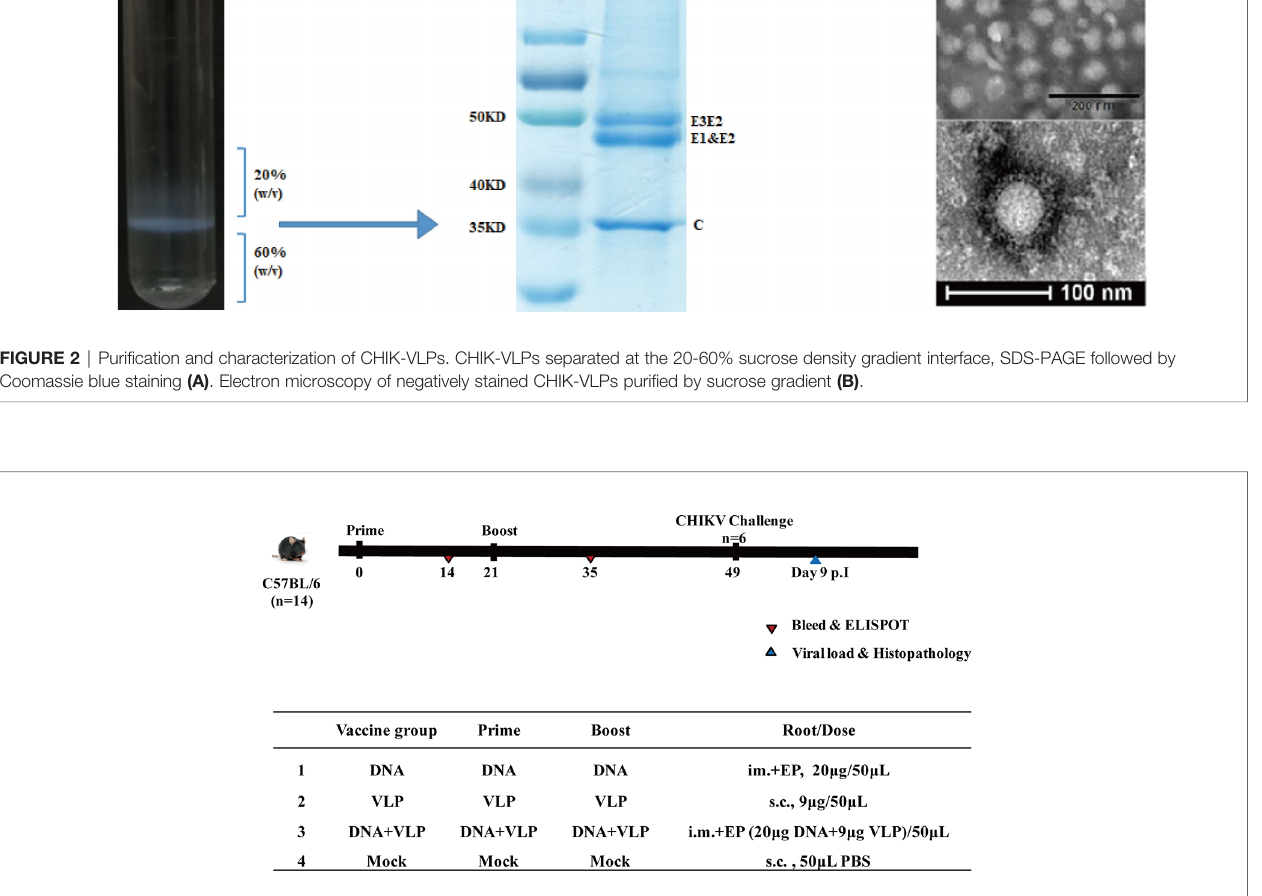
FIGURE 3 | Immunization and challenging schema of CHIKV vaccines. Mice (n=14 per group) were either mock immunized with PBS or vaccinated with DNA, VLP or DNA+VLP. Blood (n=10) was collected for humoral immune response detection at day14 and 35 by ELISA and plaque reduction neutralization assays at day 35. 14 days after the prime and boost immunization, mice (n=4) were sacri fi ced and cellular immune responses were analyzed in splenocytes. Mice (n=6) were challenged with 1.7×10 7 TCID 50 of the CHIKV Ross by intranasal infection at day 49. Body weight, survival rate, tissue viral load, and histopathological changes were